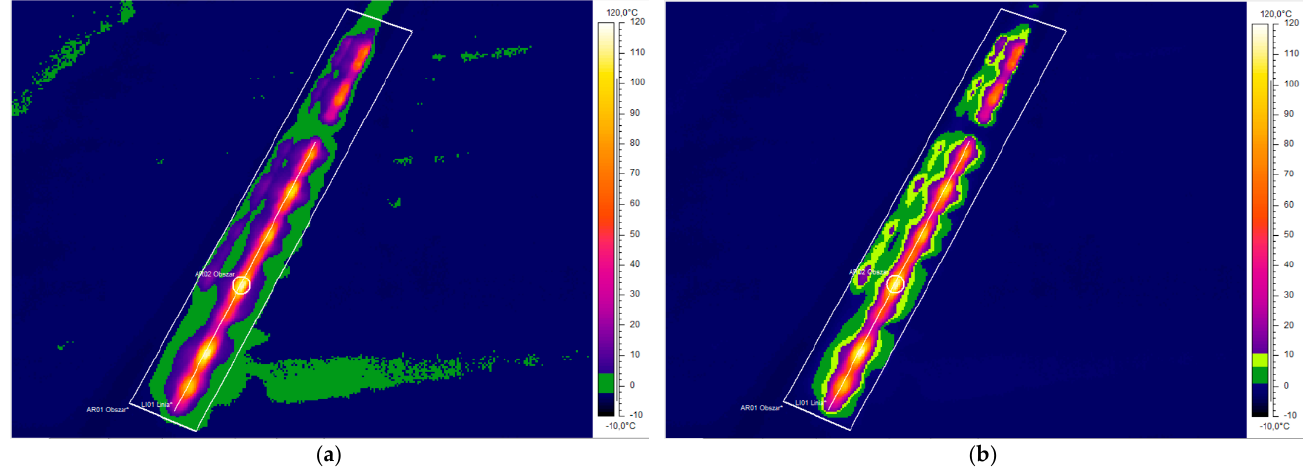
Figure 15. Thermographs: ( a ) zoomed region of interest IR_0145, iron colour palette, isotherm tool defined, ( b ) the two levels of the isotherm tool span.